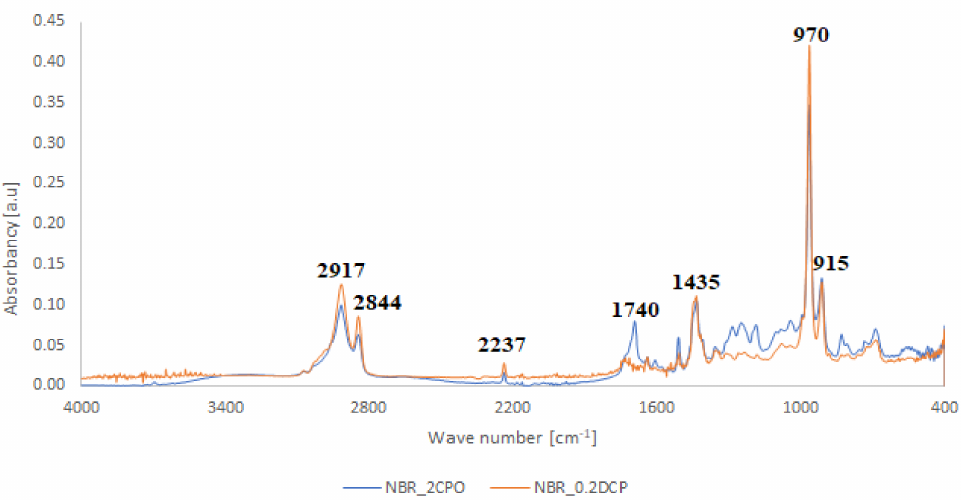
Figure 4. Comparison between the FTIR spectra of NBR crosslinked with CPO oligomer (NBR_2CPO) and DCP